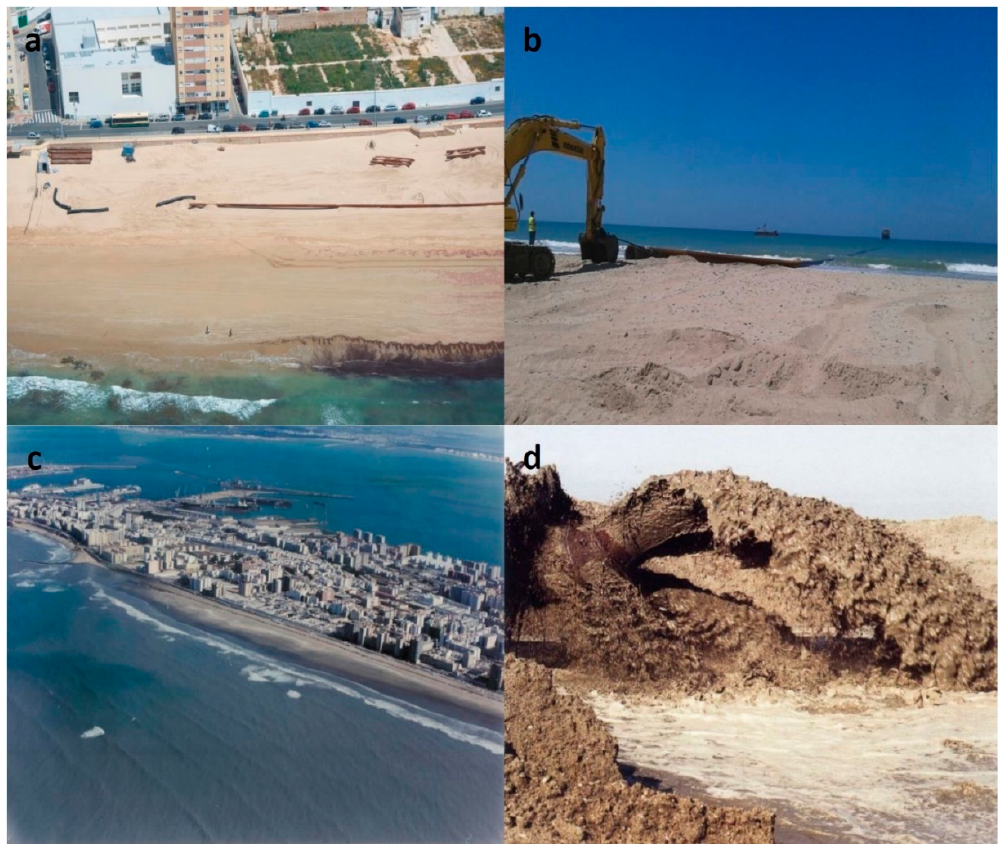
Figure 4. Different aspects of the sediment pouring on Victoria Beach, showing ( a ) pipe assembly; ( b ) transport of the pipe to the sea; ( c ) aerial view of the pipe while pouring; and ( d ) pipe outlet onto the beach.